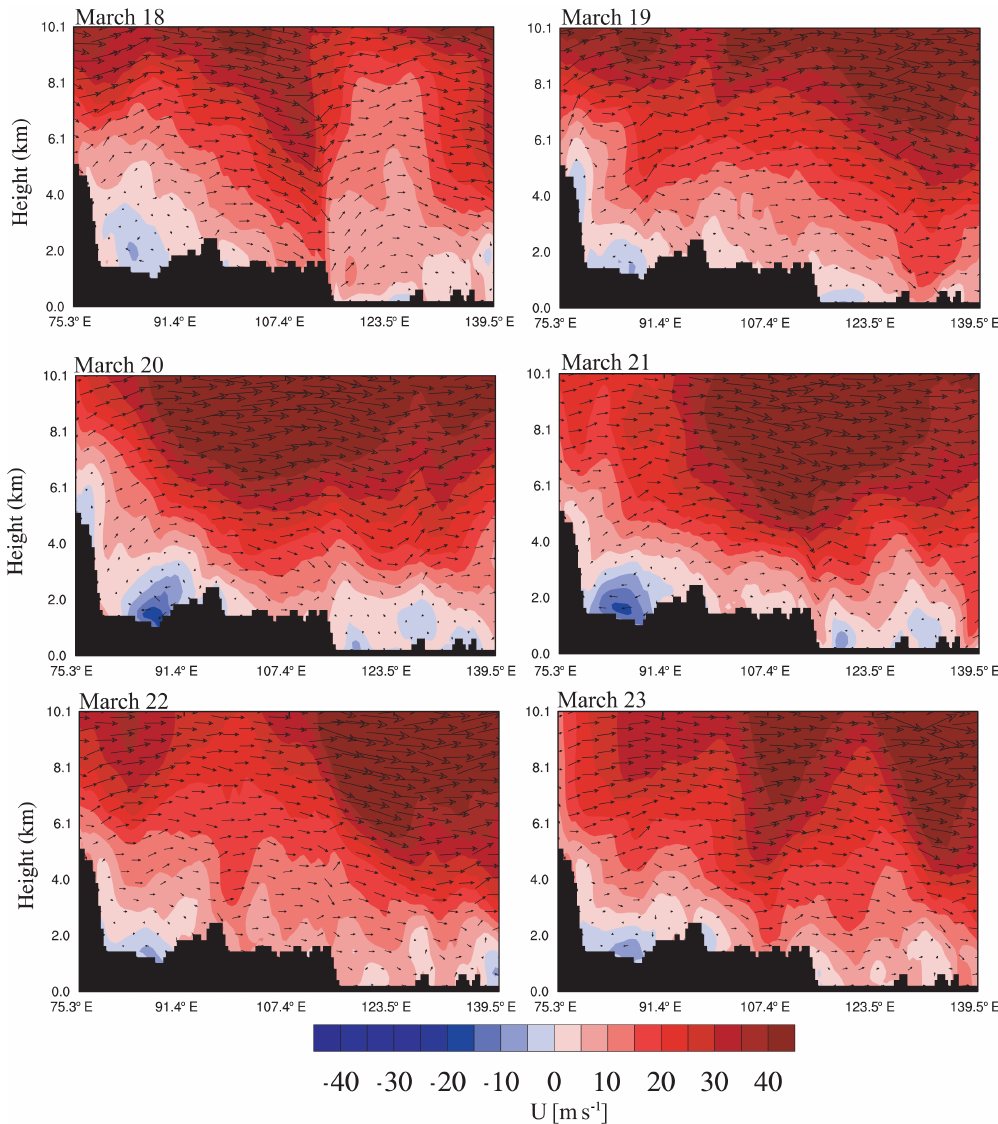
Figure 11. Cross sections of the zonal wind (m × s − 1 ) and wind vector (vertical wind scaled by 10 2 ) along 42 ◦ N during the simulation period from the WRF-Chem